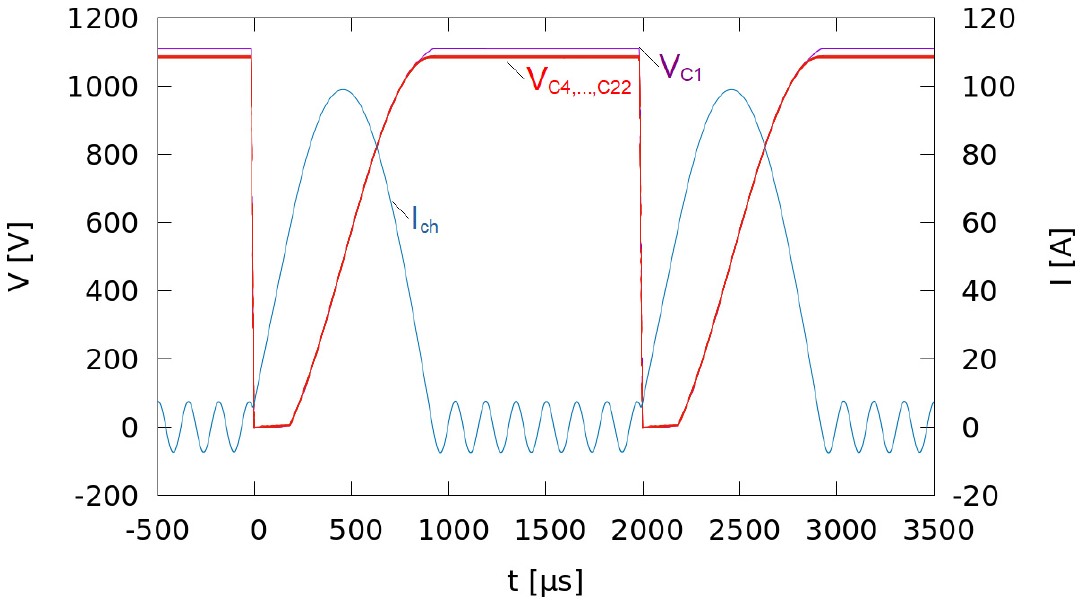
L3, L4 according to Figure 3, R D = 20 Ohm, on-time of the solid-state switches: t on = 200 µs).